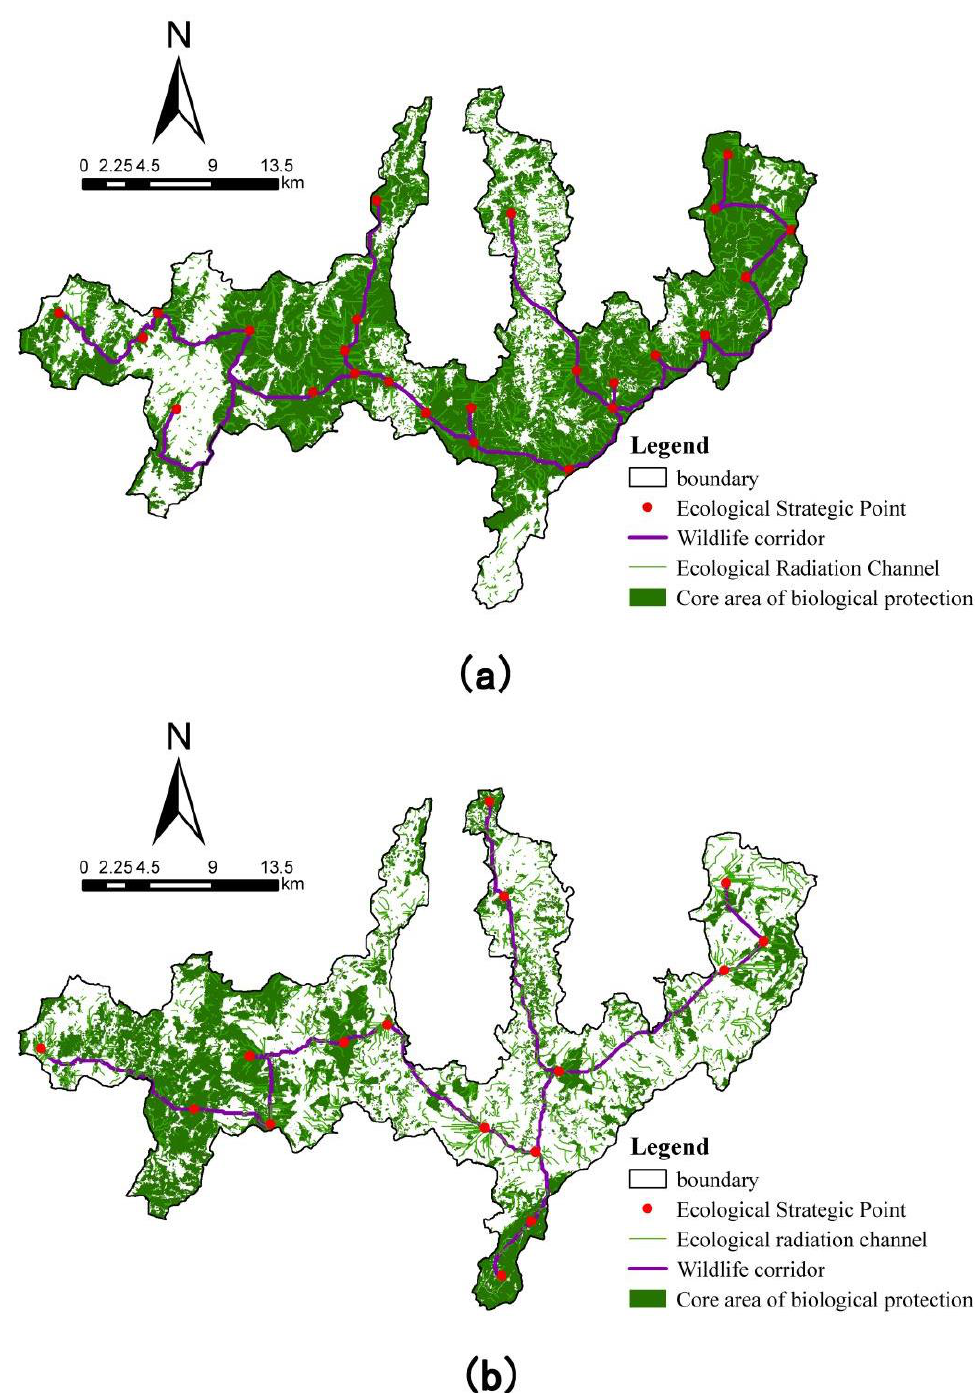
Figure 6. ( a ) Leiothrix lutea conservation security pattern map and ( b ) Emberiza aureola conservation security pattern map.